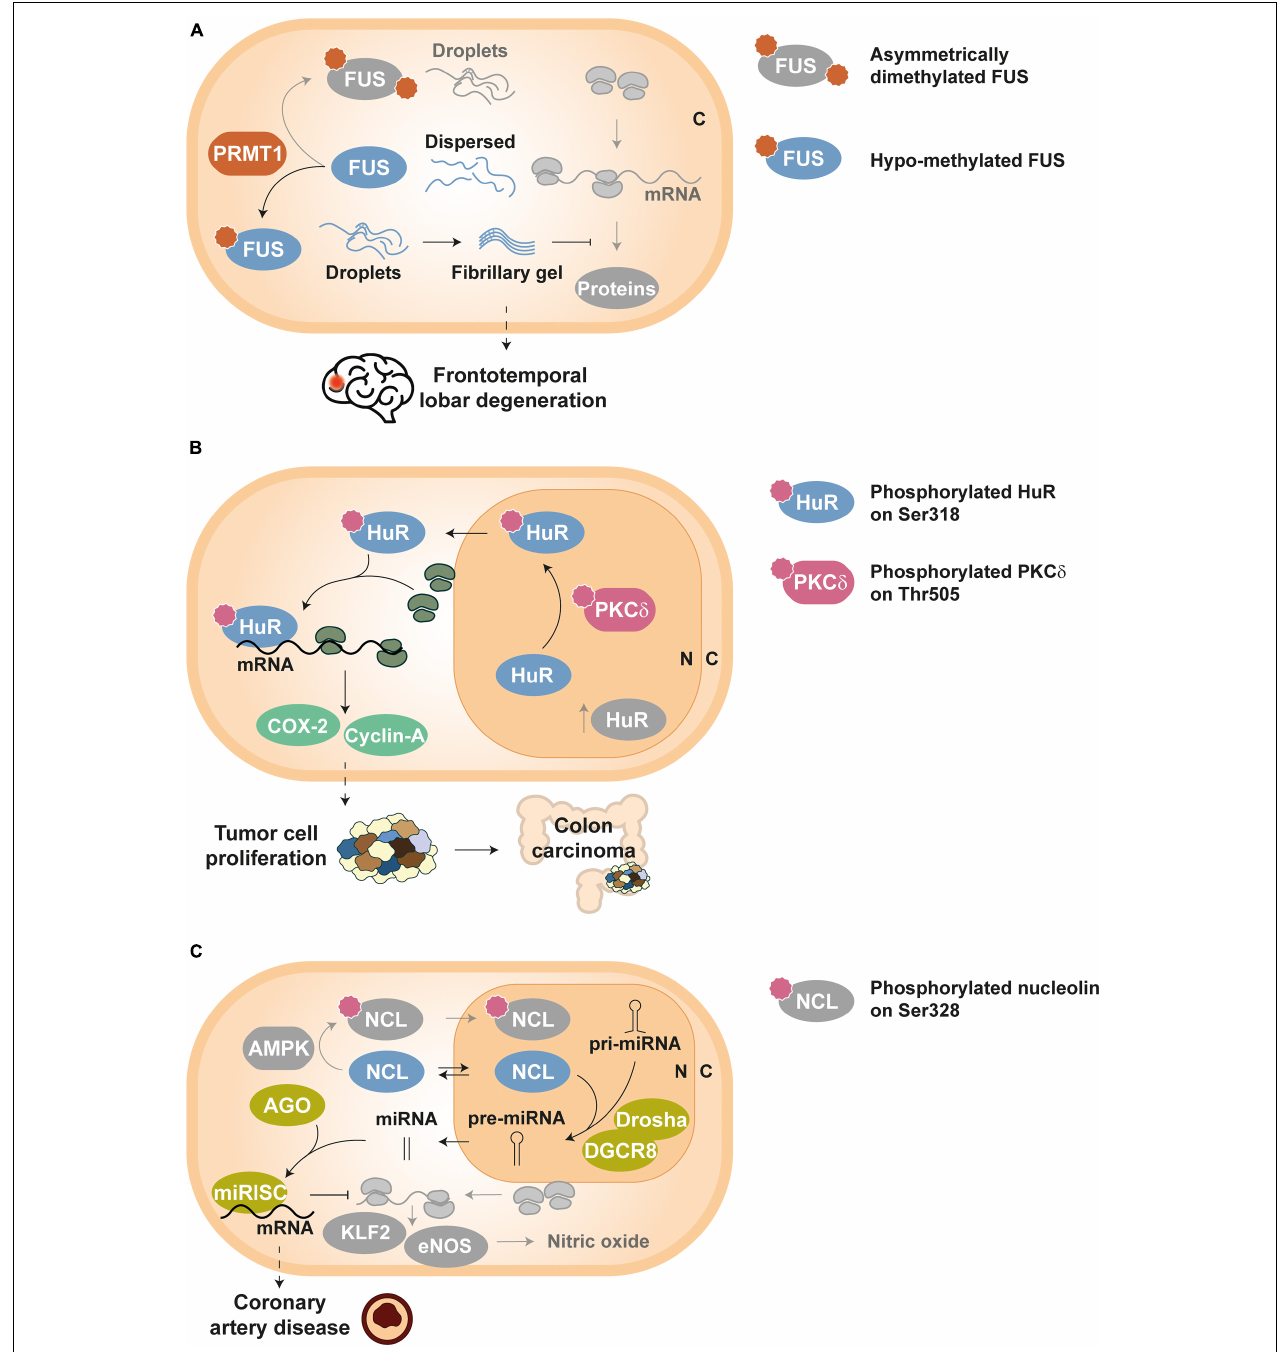
FIGURE 2 | Examples of disease-related dysregulation of PTMs in RBPs. Proteins and components involved in homeostatic pathways are depicted in grayscale, except symbols that stand for PTMs. (A) Frontotemporal lobar degeneration (FTLD): FUS molecules can build either droplets or droplets evolving into fibrillary gel state depending on its arginine methylation level, which is controlled by PRMT1 enzymes. Asymmetrically dimethylated FUS yields physiological droplets under homeostatic conditions, whereas hypo-methylated FUS forms highly stable fibrillary gels in FTLD; such fibrillary gels impede normal activity of RNP granules and decrease protein synthesis in neurons (Qamar et al., 2018). (B) Tumor cell proliferation: HuR is translocated from the nucleus (N) to the cytoplasm (C) upon PKC δ -dependent phosphorylation at Ser318, thus increasing the stability of tumor related transcripts such as COX-2 and cyclin-A. Elevated levels of Ser318-phosphorylated HuR have been detected in colon carcinoma (Doller et al., 2011). (C) Coronary artery disease: unphosphorylated NCL can shuttle between cytoplasm (C) and nucleus (N), and participates in the processing of key pri-miRNAs by the Drosha-DGCR8 complex. Such mature miRNAs associate with AGO proteins to activate the miRISC complex and thus guide the degradation of KLF2 and eNOS mRNAs. As a result, nitric oxide levels in endothelial cells decrease, producing vascular dysfunction (Gongol et al., 2019).